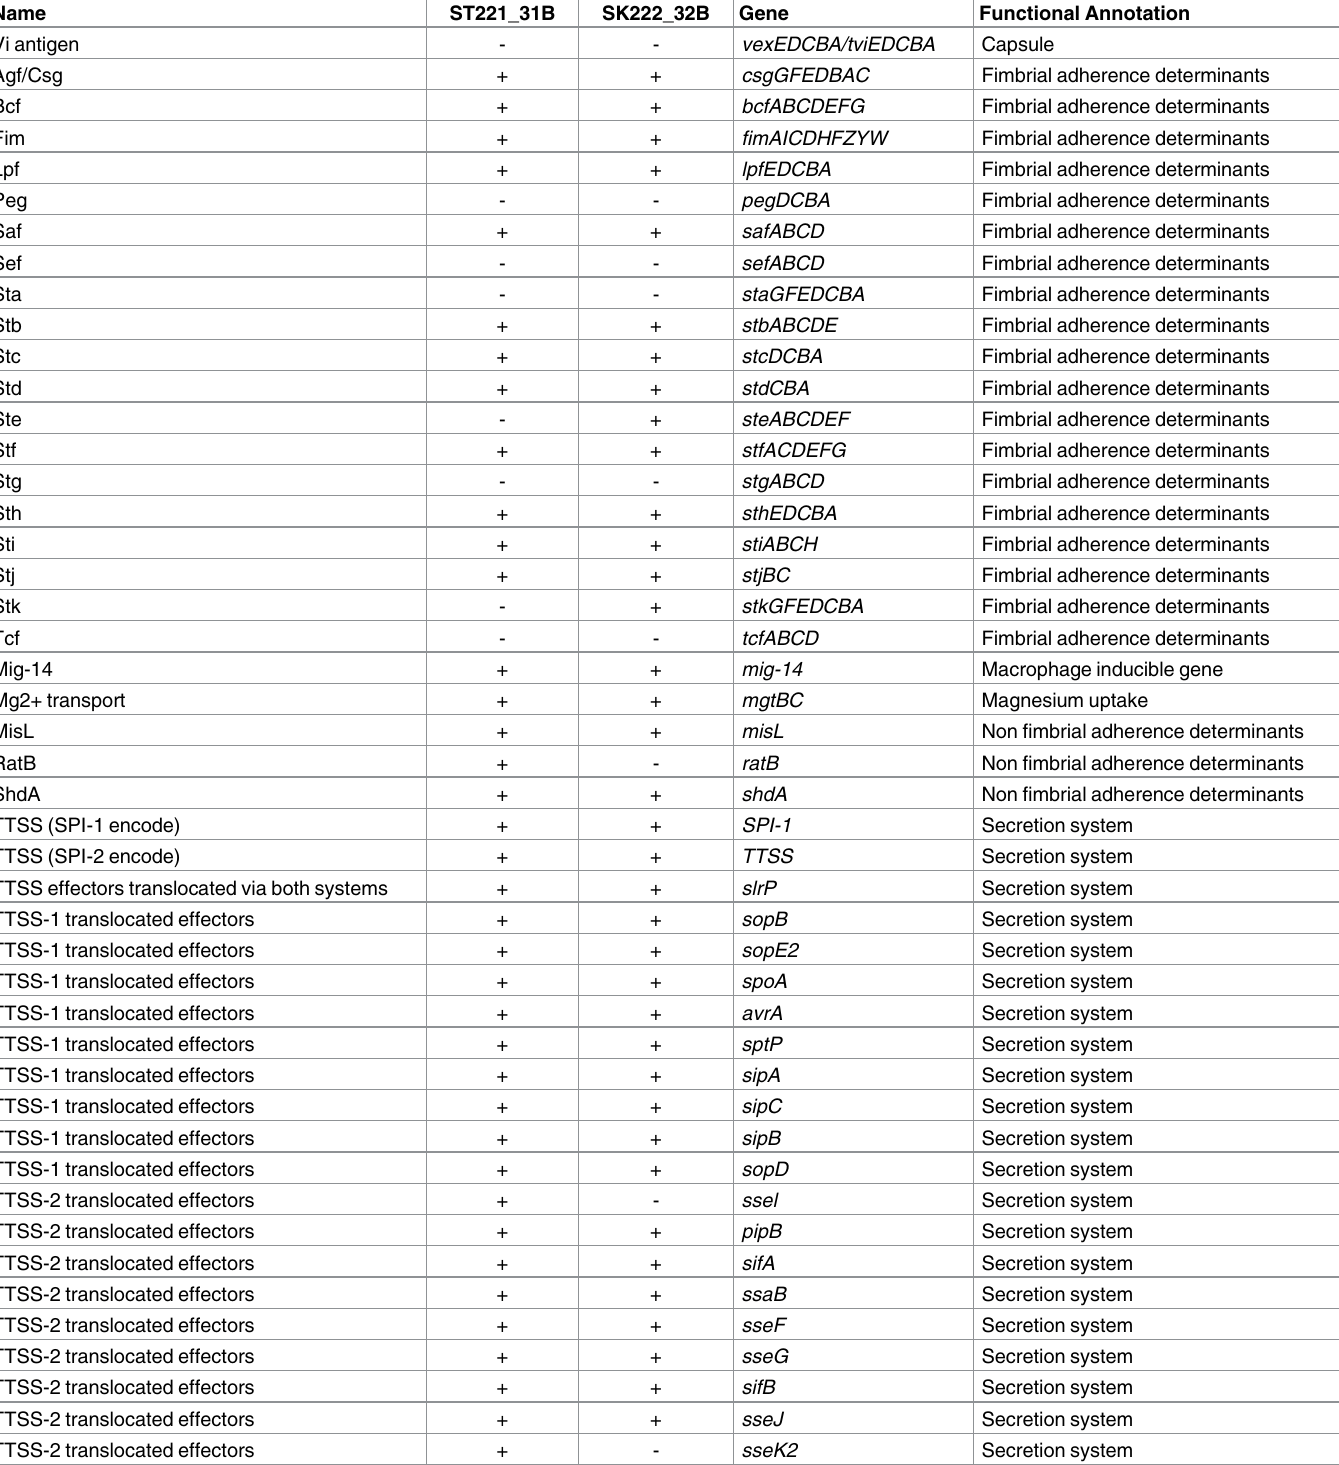
Table 2. Virulence determinants of ST221_31B and SK222_32B, as determined by querying each genome against the virulence factors of patho- genic bacteria